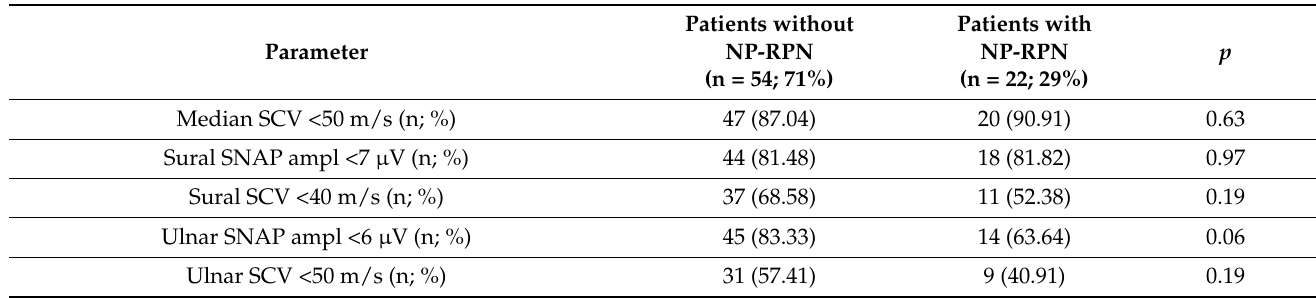
Table 5. Selected Spearman rank correlations between severity of neuropathic pain related to peripheral neuropathy (1–4 quantitative score) and the presence of abnormalities in neurological examination and neurophysiological parameters.